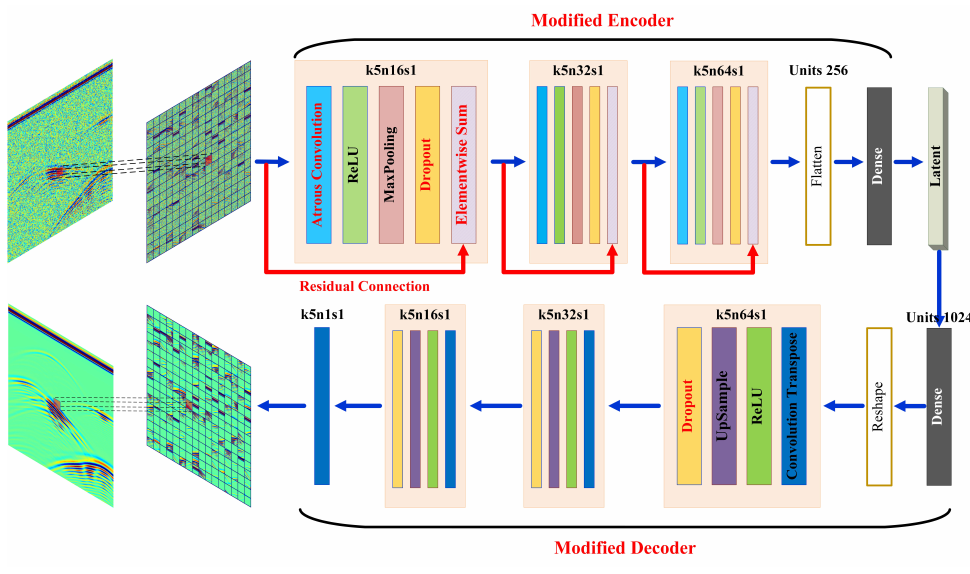
Figure 5. Structure of